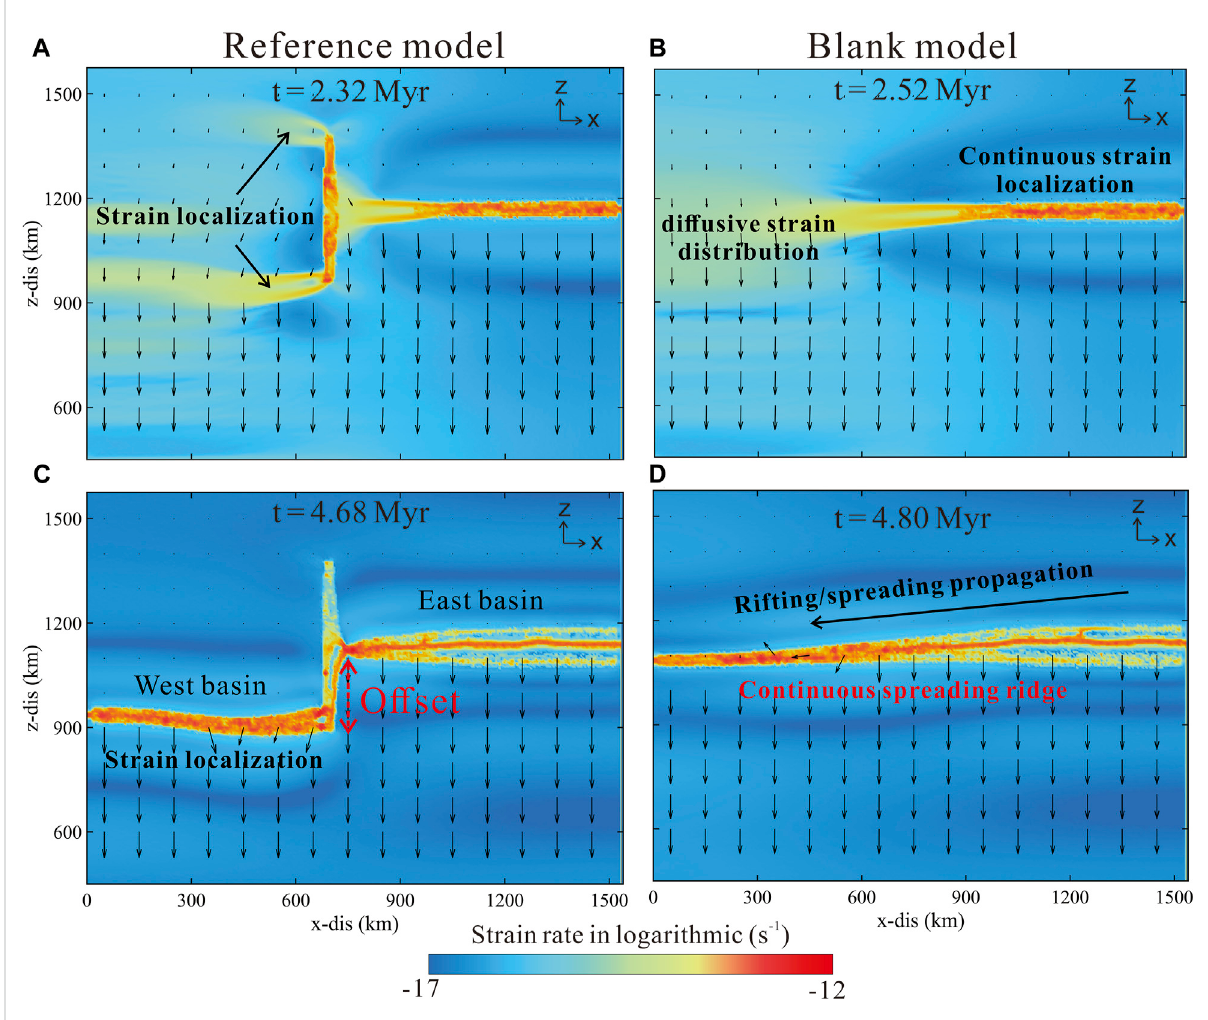
FIGURE 6 Comparison between the reference model and the blank model (A – D) Map view of strain localization. Background color represents strain rate and arrows are velocity